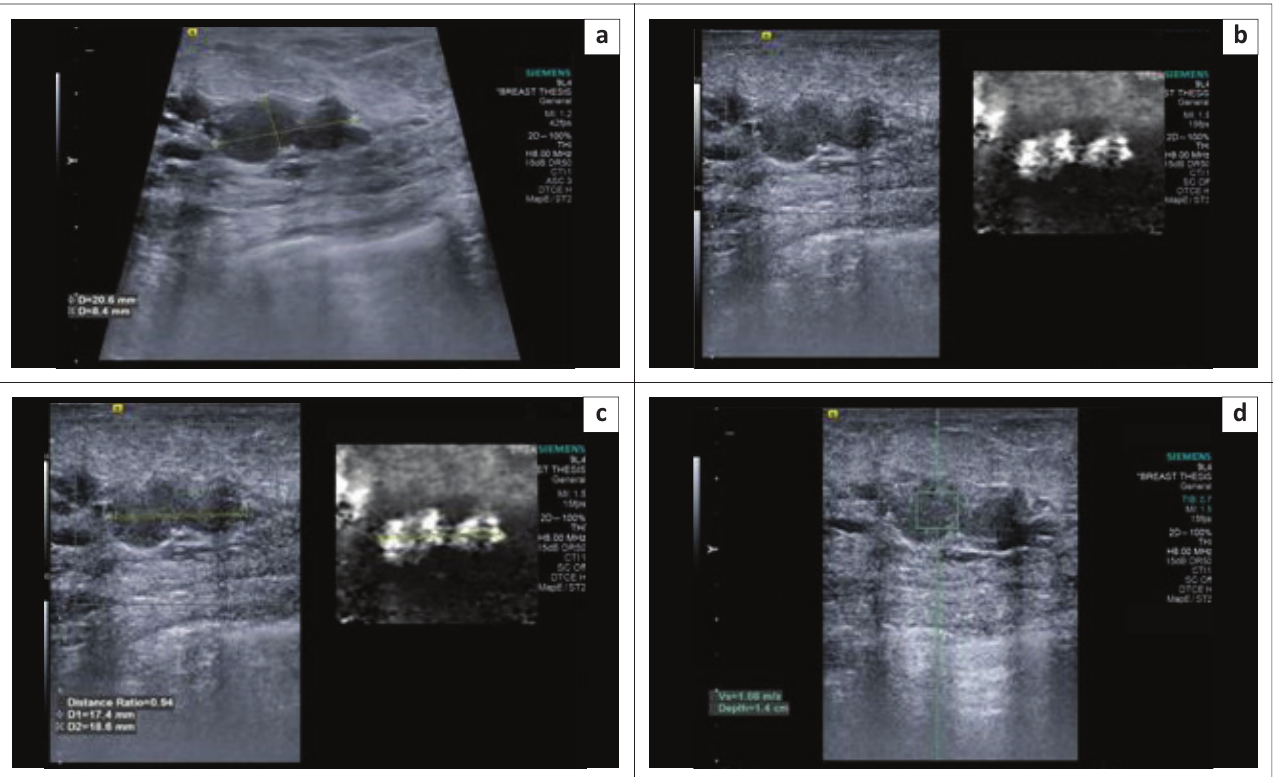
FIGURE 1: (a) B-mode ultrasonography image demonstrating a hypoechoic, lobulated lesion oriented parallel to the skin; (b) virtual touch imaging elastogram showing the lesion to be bright in comparison to the adjacent breast parenchyma, suggesting a soft lesion; (c) distance ratio of < 1 (0.94); (d) shear wave velocity in the lesion – 1.66 m/s. The final histopathology report was a fibroadenoma.